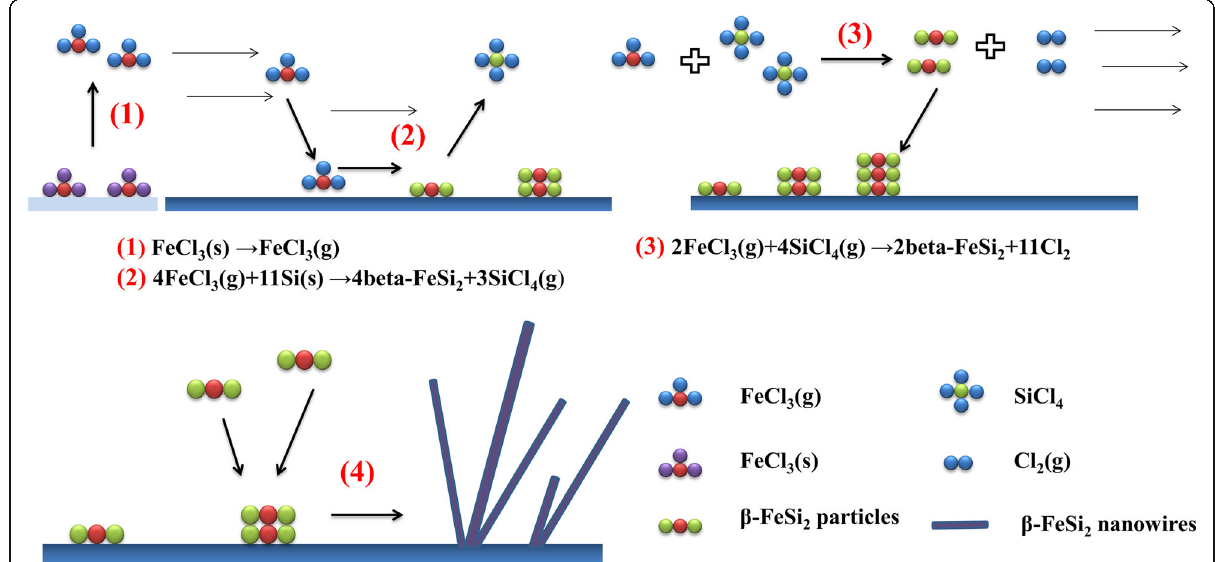
Fig. 3 Schematic illustration of the growth mechanism 1 FeCl 3 (s) → FeCl 3 (g); 2 4FeCl 3 (g) + 11Si(s) → 4 β -FeSi 2 + 3SiCl 4 (g); 3 2FeCl 3 (g) + 4SiCl 4 (g) → 2 β -FeSi